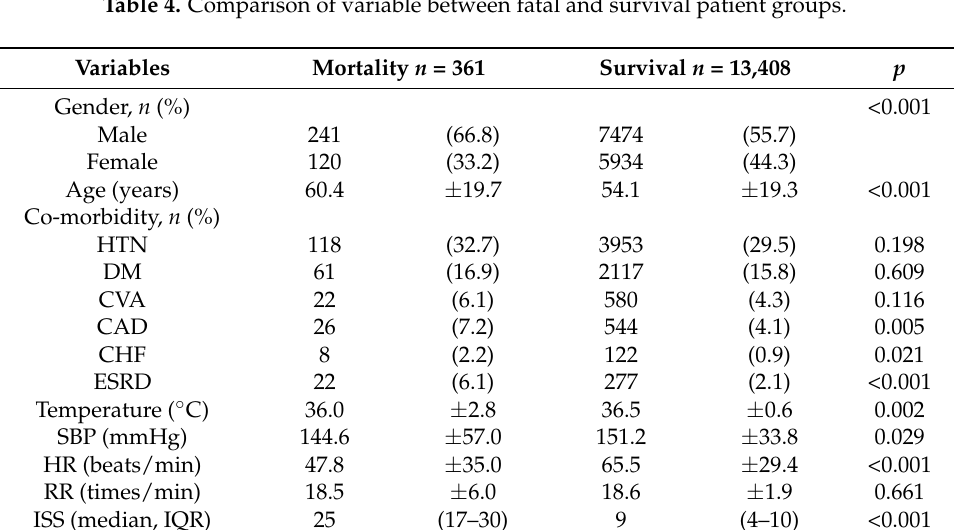
Table 4. Comparison of variable between fatal and survival patient